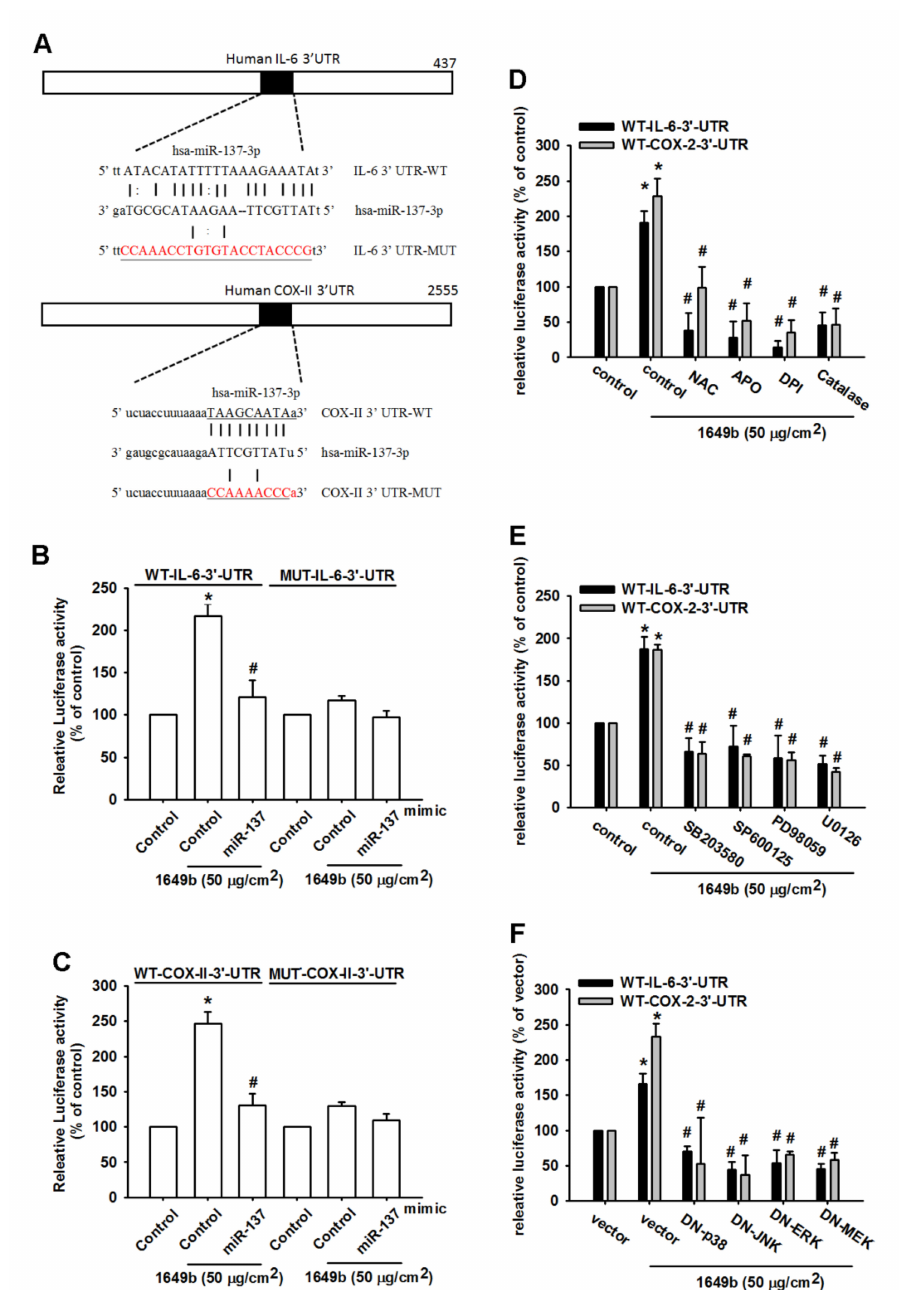
Figure 5. PMs increases IL-6 and COX-II-expression via inhibition of hsa-miR-137 through the MEK, ERK, p38 and JNK signaling pathways. ( A ) Schematic 3’-UTR representation of human IL-6 and COX-II containing the hsa-miR-137 binding site; ( B , C ) Cells were transfected with indicated luciferase plasmids before incubation with PM2.5 for 24 h; Luciferase activity was assessed; ( D – F ) Incubation with ROS, MEK, ERK, JNK and p38 inhibitors or MEK, ERK, JNK and p38 MAPK mutants reversed PM-mediated IL-6 and COX-II-3’-UTR luciferase activity. Results are expressed as the mean ± SD. * p < 0.05 as compared with baseline. # p < 0.05 as compared with the PM2.5-treated